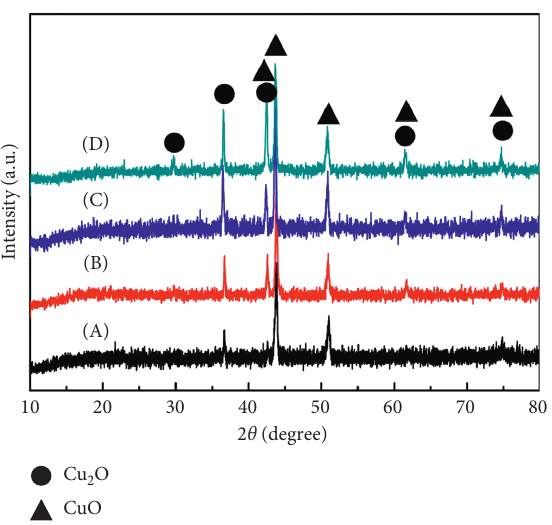
Figure 11: XRD spectra of CuO-Cu